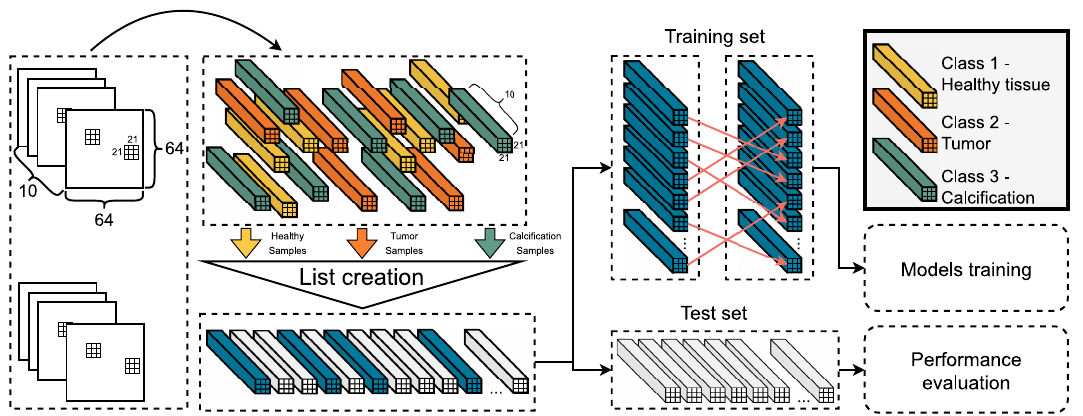
Figure 3. This figures depicts the third stage of the proposed AI framework. The selected patches are transformed into tensor objects, which are then stored in a temporary list. After a sampling process, the training and the testing sets are formed. A permutation is applied to the former and both of them are fed to the AI